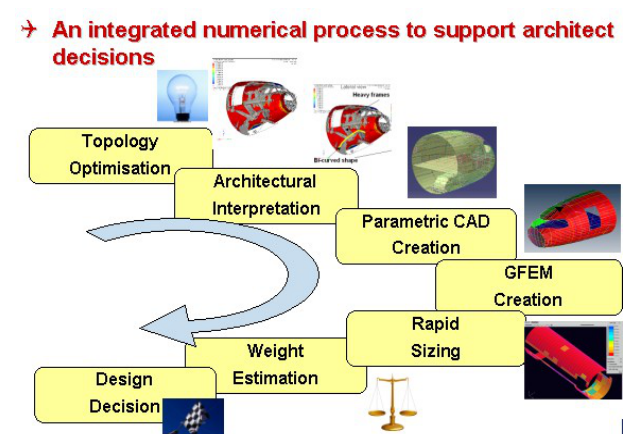
Fig. 19. A fully parameterized sizing tool